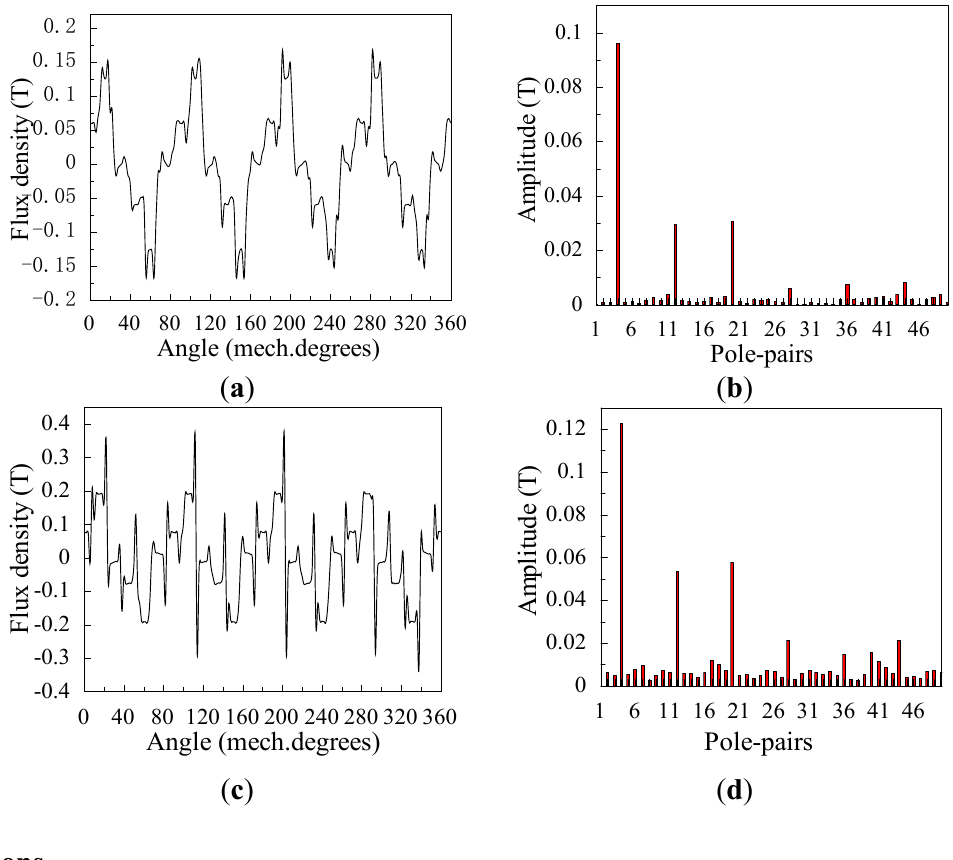
Figure 19. Axial flux density waveforms due to the stator winding, in two air gaps and corresponding space harmonic spectra: ( a ) axial flux density waveform in the air gap adjacent to the permanent magnet rotor; ( b ) the space harmonic spectrum in the air gap adjacent to the permanent magnet rotor; ( c ) axial flux density waveform in the air gap adjacent to the stator; and ( d ) the space harmonic spectrum in the air gap adjacent to the